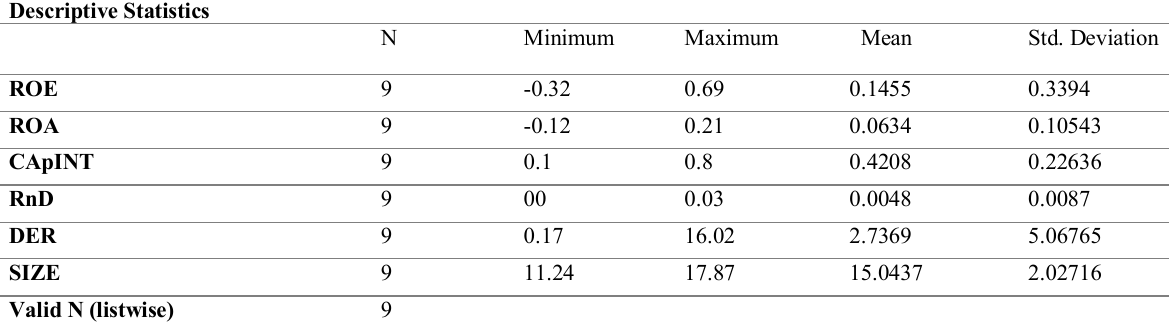
Table 1: Descriptive statistics of the